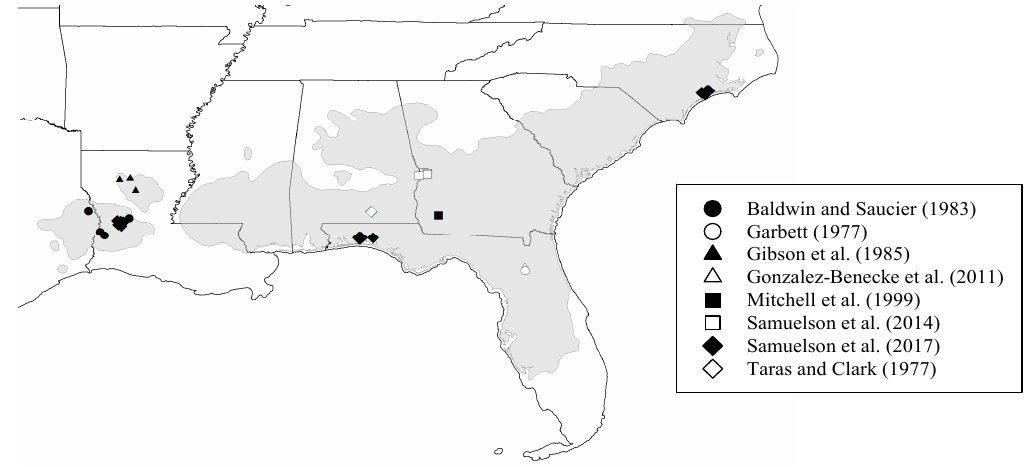
Figure 1. Location of the study sites for longleaf pine within the species natural distribution range (grey area).